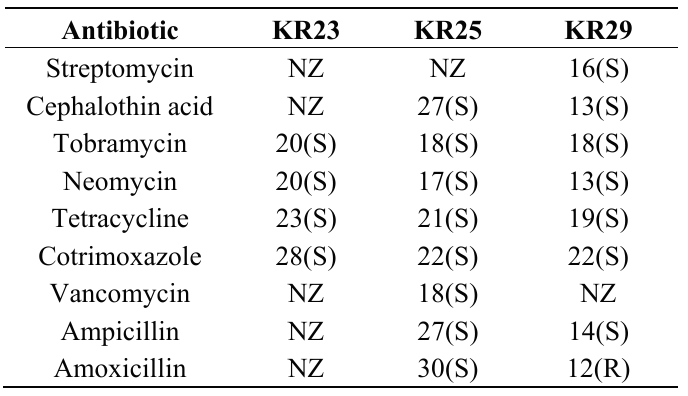
Table 3. Antibiotic profiles of isolates before curing [3].